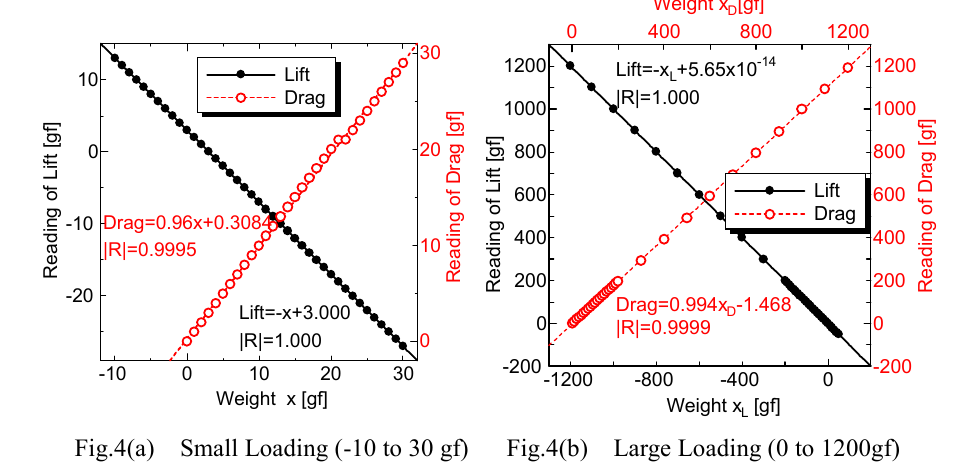
Calibration Curves of Lift and Drag Components in a Small Scale Load (-10 to 30 gf) and a Large Scale Load (0 to 1200 gf) The sign of lift component is reversed in order to show the difference from the drag